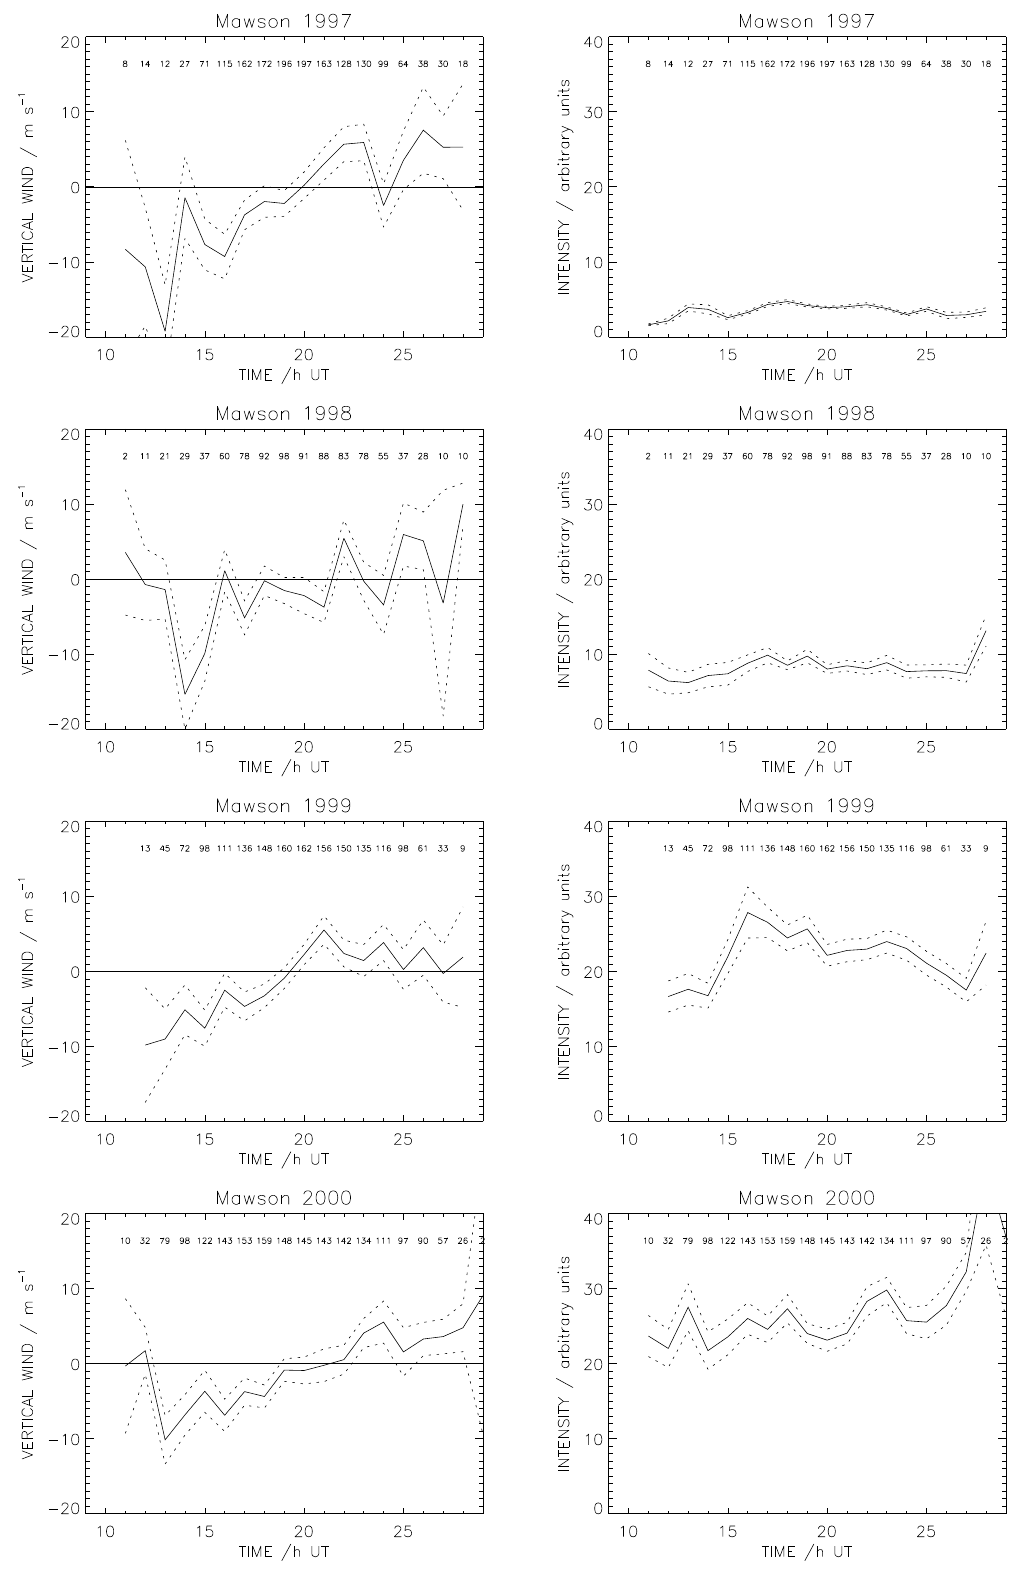
Fig. 2. Hourly averaged vertical wind and intensity for Mawson, for the years 1997–2000. Standard errors in hourly means are indicated by dashed lines. The number of points in each hourly mean is written at the top of each